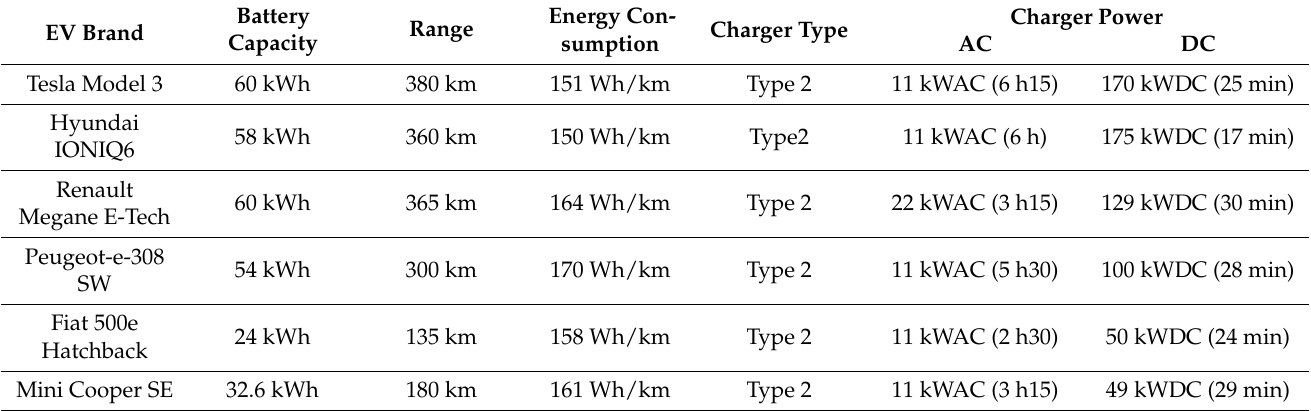
Table 1. EV Energy Consumption Based on Battery Size, Vehicle Type, and Charger